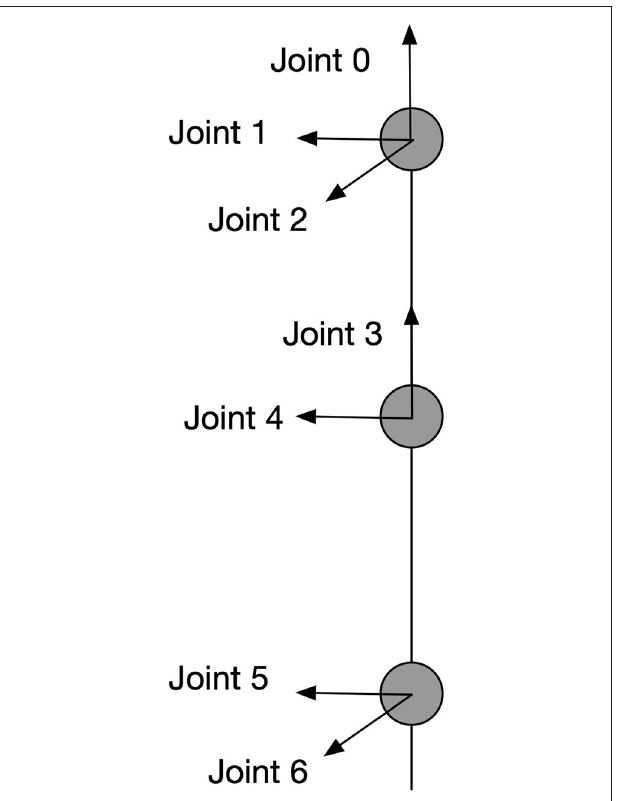
FIGURE 3 | Kinematic information of the arm model. This is a 7-DOF arm with each joint and its rotation axe shown in the figure. All the angular rotations in this paper are in terms of counter-clockwise except for joint 2 which works